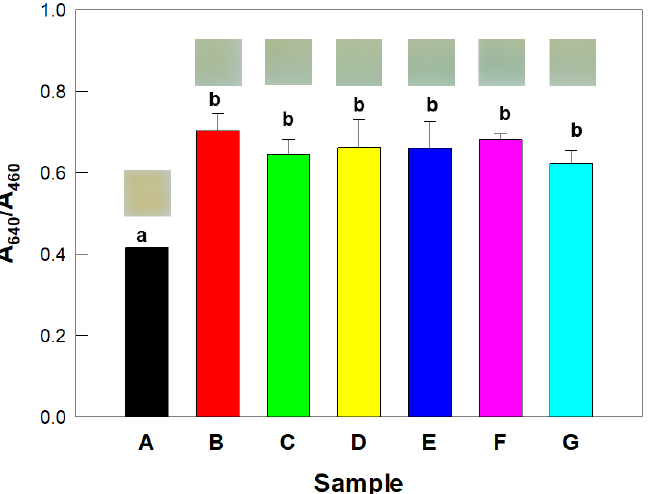
Figure 6. Colorimetric detection of urease activity of Klebsiella pneumoniae ( K. pneumoniae ) in the presence of non-ureolytic bacteria. The A 640 /A 460 values and photographs of film sensors each acquired after an incubation duration of 10 h. A: Citrobacter koseri ( C. koseri ) + Escherichia coli ( E. coli ) + Klebsiella michiganensis ( K. michiganensis ) + Providencia alcalifaciens ( P. alcalifaciens ) (non-ureolytic bacteria only), B: K. pneumoniae only, C: K. pneumoniae + C. koseri , D: K. pneumoniae + E. coli , E: K. pneumoniae + K. michiganensis , F: K. pneumoniae + P. alcalifaciens , and G: K. pneumoniae + C. koseri + E. coli + K. michiganensis + P. alcalifaciens . Different lowercases indicate a statistical significance between the means of sample sets at a significance level ( p -value) of 0.05.